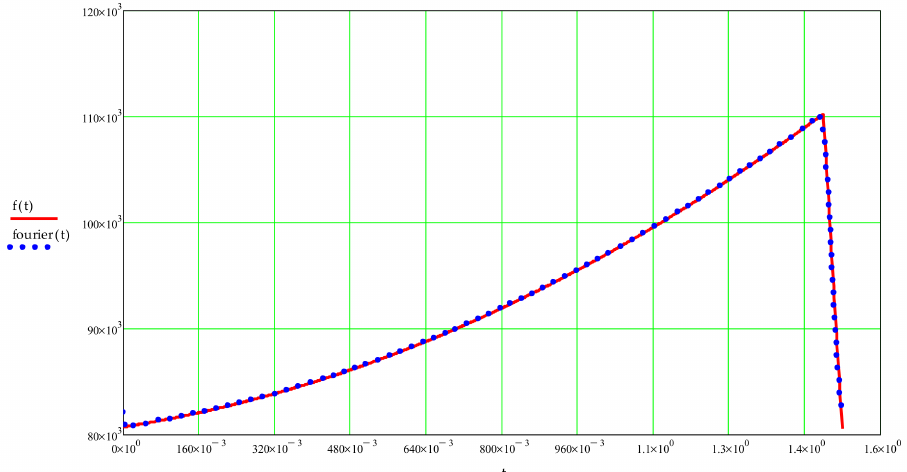
Figure 8. Force variation using Fourier series development for one period.